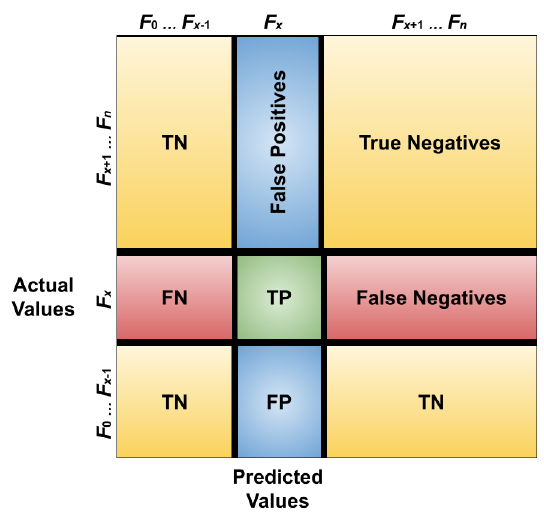
Figure 3. Multi-classification confusion